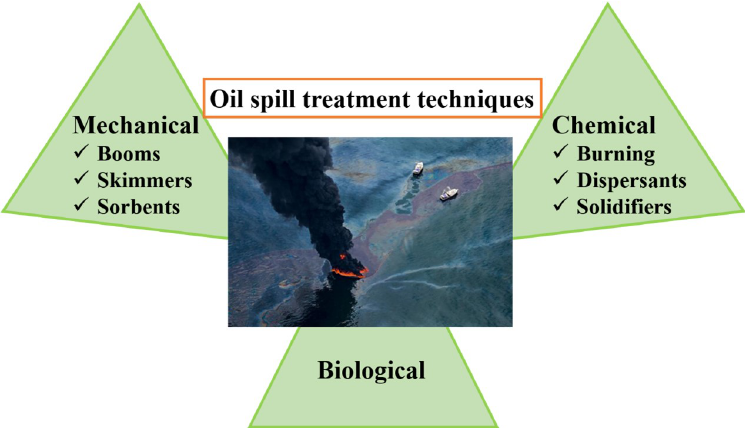
Figure 1. Three types of main techniques used for treating oil spills.